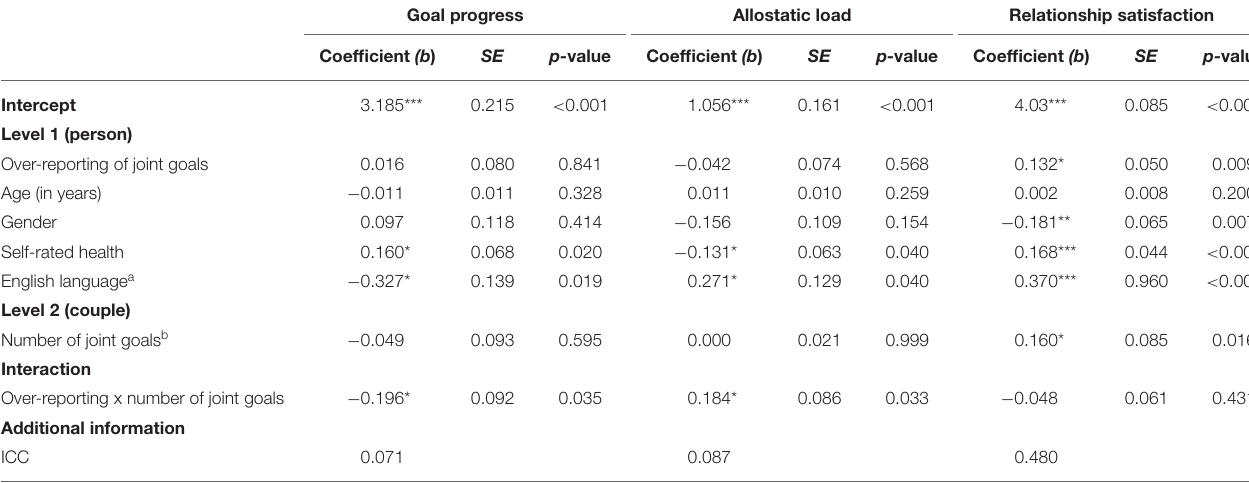
TABLE 3 | Multilevel analysis with goal progress, relationship-satisfaction, and allostatic load as outcome variables ( N = 118